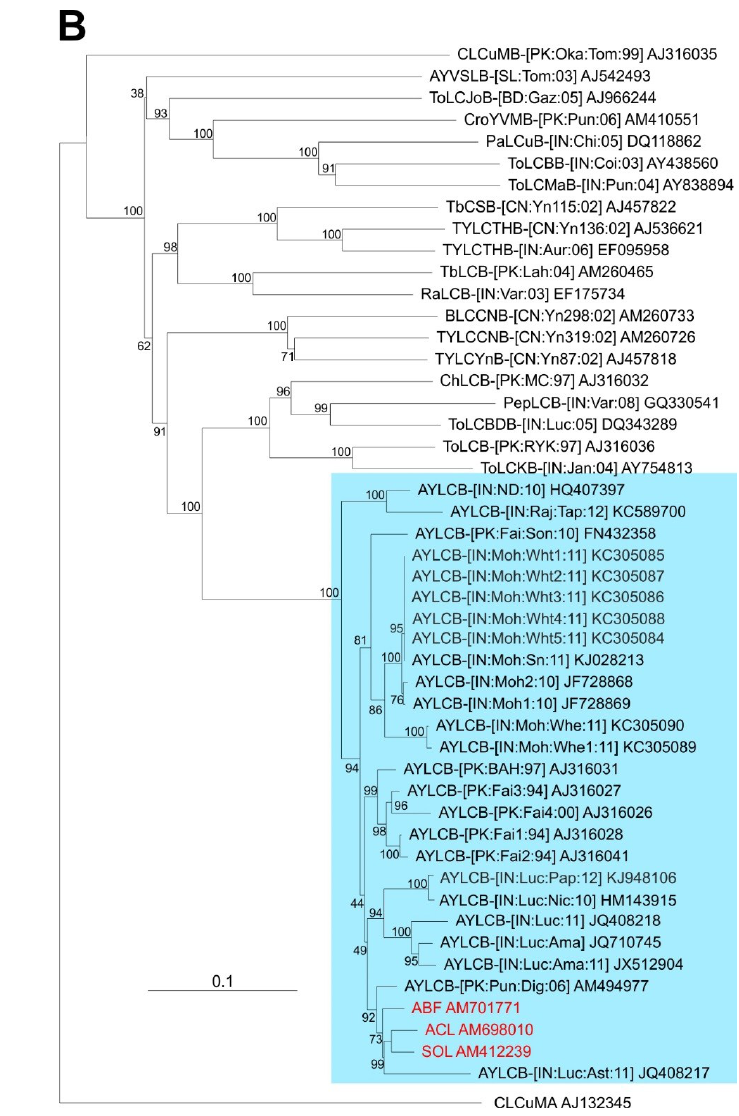
Figure 2. Phylogenetic analyses of begomovirus and betasatellite sequences. Phylogenetic dendrograms based upon alignments of the complete nucleotide sequences of the genomes (or DNA A genomic components of) begomoviruses ( A ) and betasatellites ( B ) identified here with selected sequences available in the databases. The Neighbour-joining method was used for construction of the phylogenetic dendrograms. Horizontal distances are proportional to mutation distances whereas vertical distances are arbitrary. The numbers at each branch indicate percentage bootstrap confidence scores (1000 replicates). The begomovirus acronyms used are Ageratum enation virus (AEV), Ageratum yellow vein Sri Lanka virus (AYVSLV), Bitter gourd yellow vein virus (BGYVV), Chili leaf curl virus (ChiLCV), Cotton leaf curl Multan virus (CLCuMV), Croton yellow vein mosaic virus (CYVMV), Okra yellow vein mosaic virus (OYVMV), Mungbean yellow mosaic India virus (MYMIV), Papaya leaf curl virus (PaLCuV), Pedilanthus leaf curl virus (PedLCV), Pepper leaf curl Bangladesh virus (PepLCBDV), Pepper leaf curl Lahore virus (PepLCLV), Radish leaf curl virus (RaLCV), Squash leaf curl China virus (SLCCNV), Tobacco curly shoot virus (TbCSV), Tomato leaf curl Bangladesh virus (ToLCBDV), Tomato leaf curl Gujarat